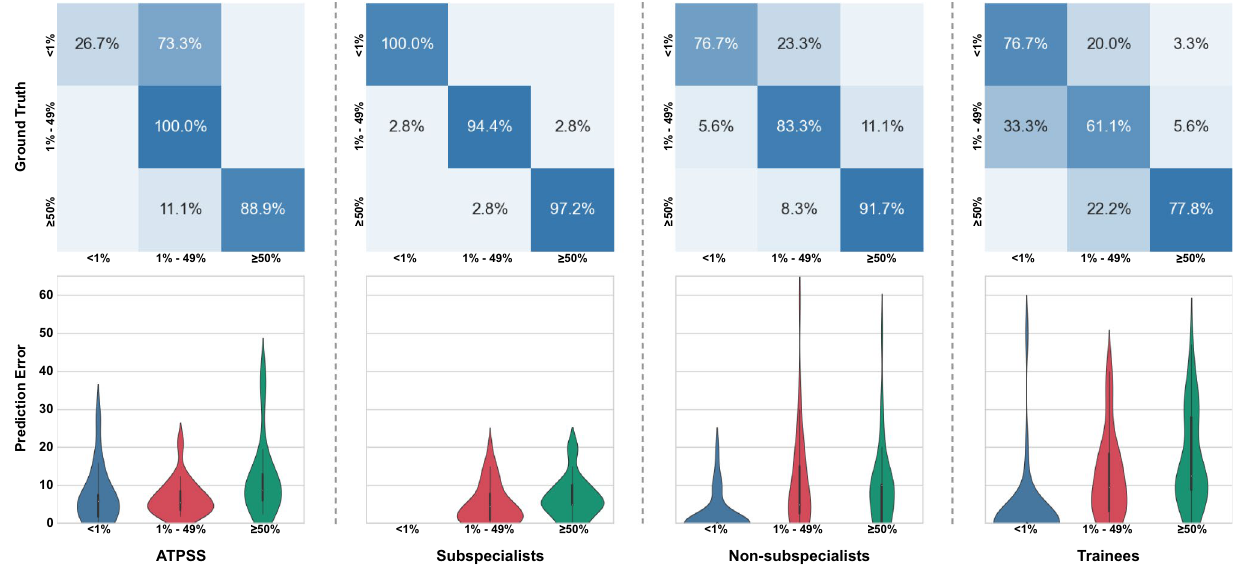
Figure 4. Results PD-L1 TPS assessment of ATPSS and pathologists on different PD-L1 expression levels. The top row presents the confusion matrices; bottom row shows the violin plots. The results of pathologists are the sum of two pathologists with same experience level. The ATPSS shows satisfactory level of accuracy on positive PD-L1 expression cases; the level of accuracy drops as the pathologist’s level of experience